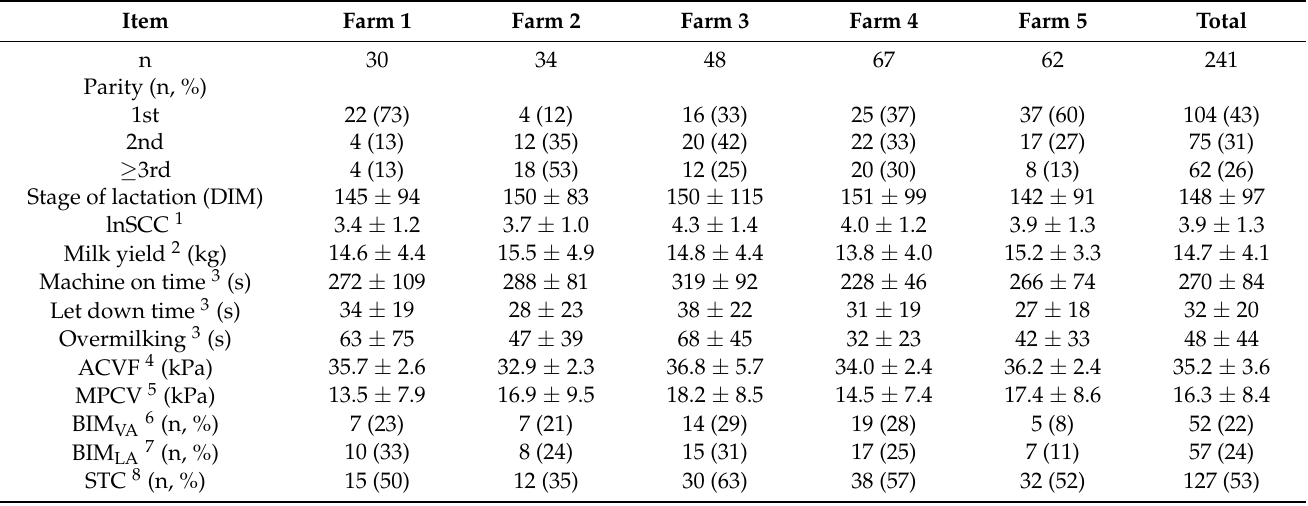
Table 2. Descriptive statistics of 241 individual cow milking observations from 5 New York dairy farms. Values presented as mean and standard deviation unless otherwise stated.